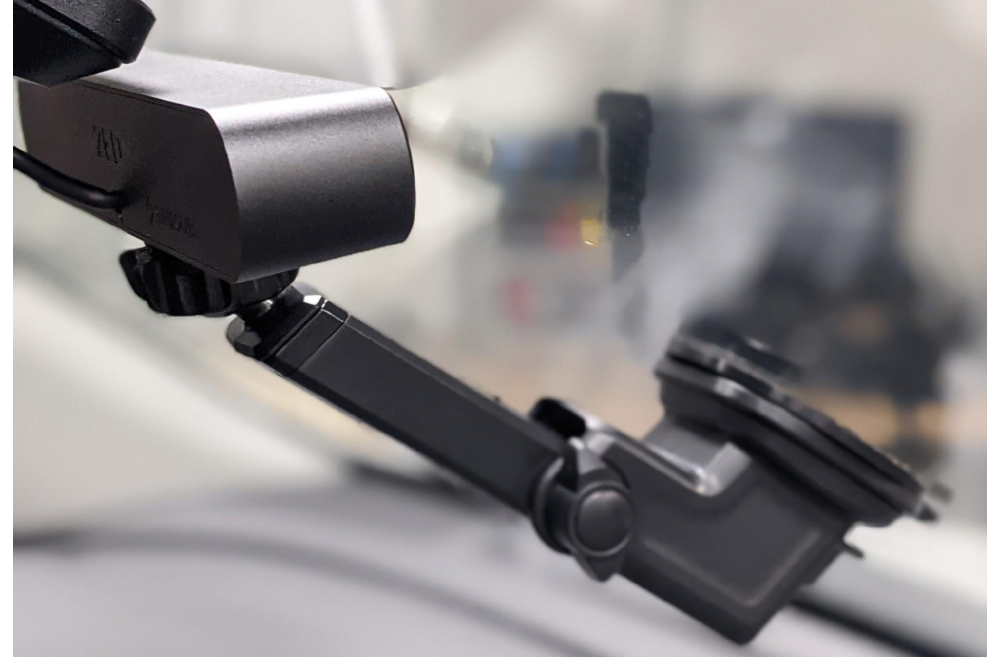
Figure 4. Mounted ZED stereo camera used for forward-facing computer